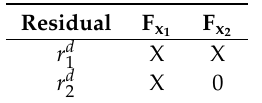
Table 1. Residual matrix for the isolation of the active fault